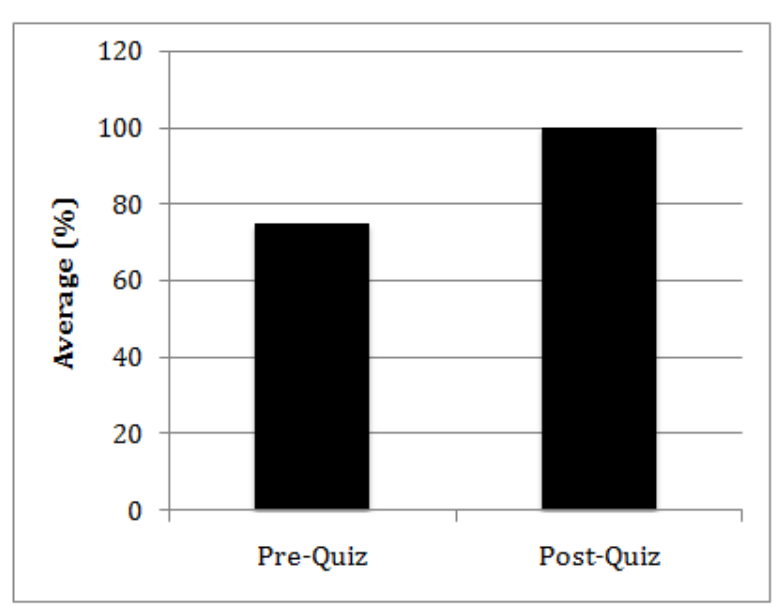
Figure 11. The overall average for the control group for the question regarding drawing a series diagram